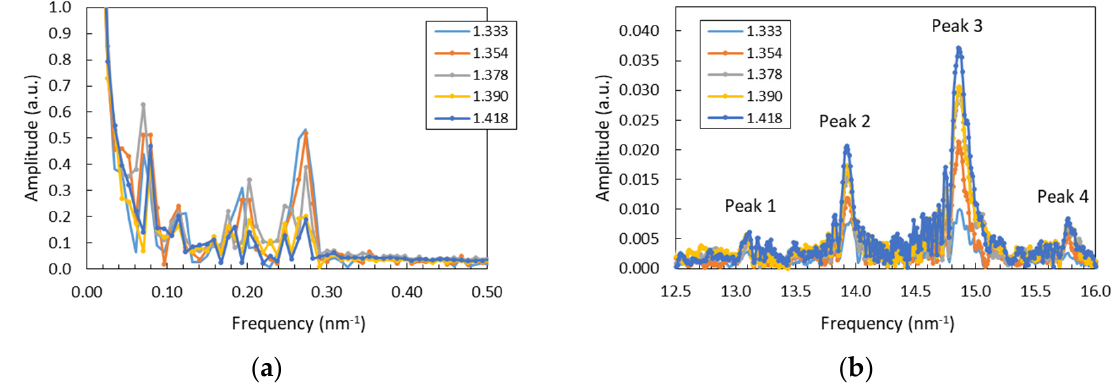
Figure 8. Spatial frequency amplitude plots for the two regions in the spectral analysis for the FP ‐ short sensor ( L 1 = 105 μ m and L 2 = 149 μ m): (a) 0.01 nm − 1 to 0.5 nm − 1 and (b) 12.5 nm − 1 to 16 nm − 1 . Each plot represents a zoom of one of the two regions in Figure 6b.